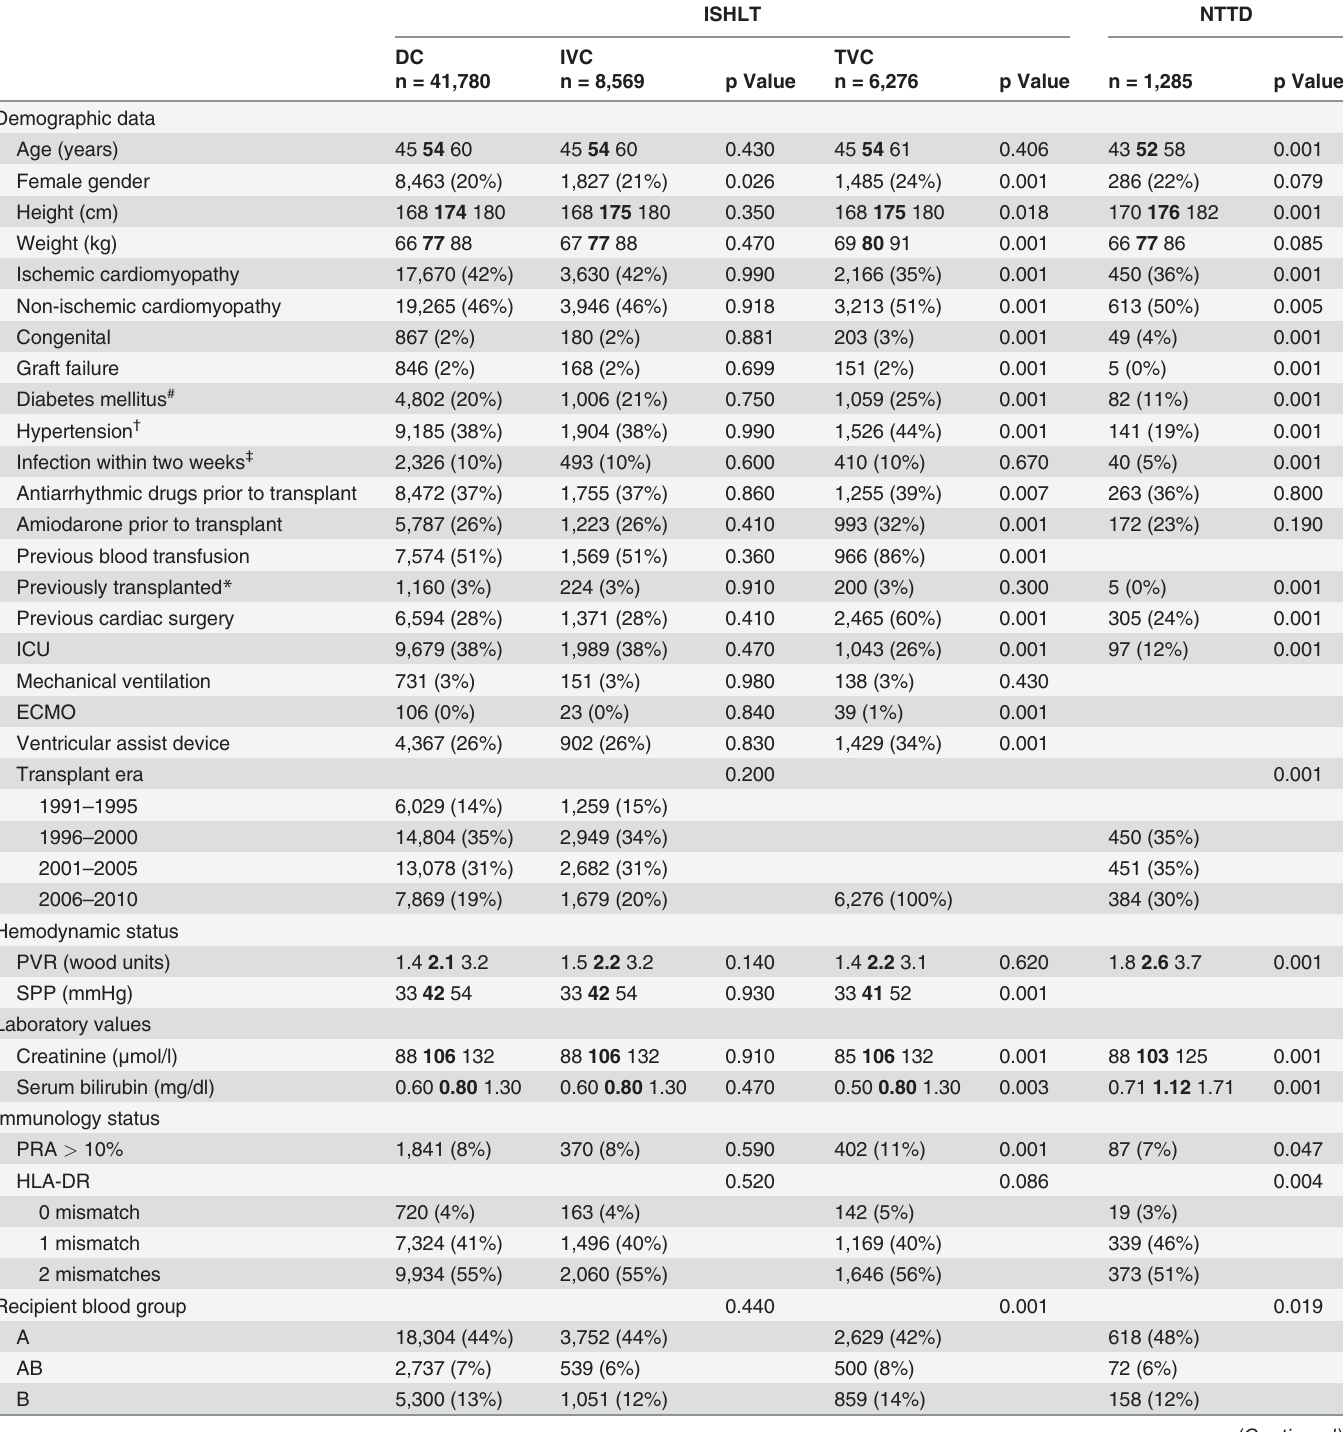
Table 1. Baseline characteristics of recipients in the derivation and validation